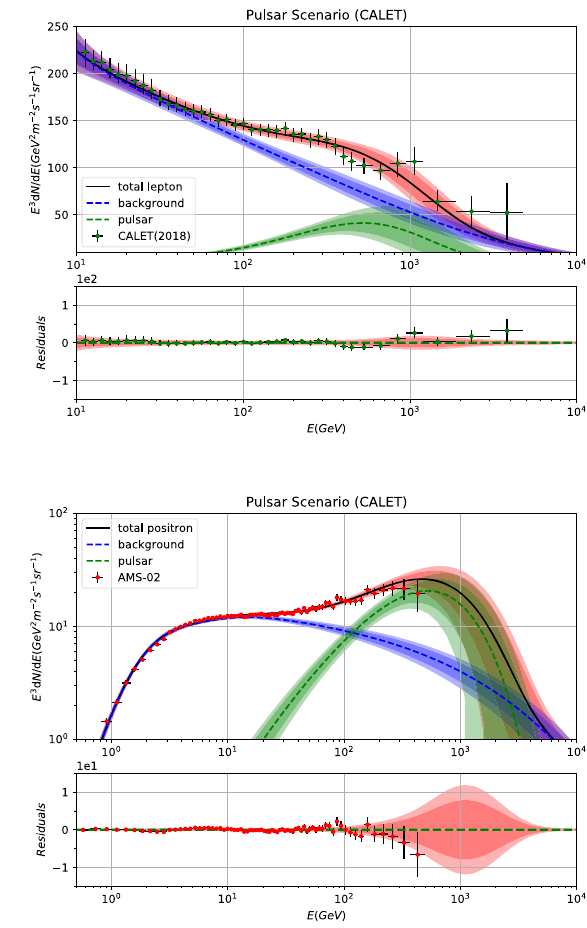
Fig. 3 The global fitting results and the corresponding residuals to the lepton (DAMPE and CALET) and positron (AMS-02) flux for pulsar scenario. The 2 σ (deep color) and 3 σ (light color) bounds of the total fitted results (red), and the contribution from background (blue) and